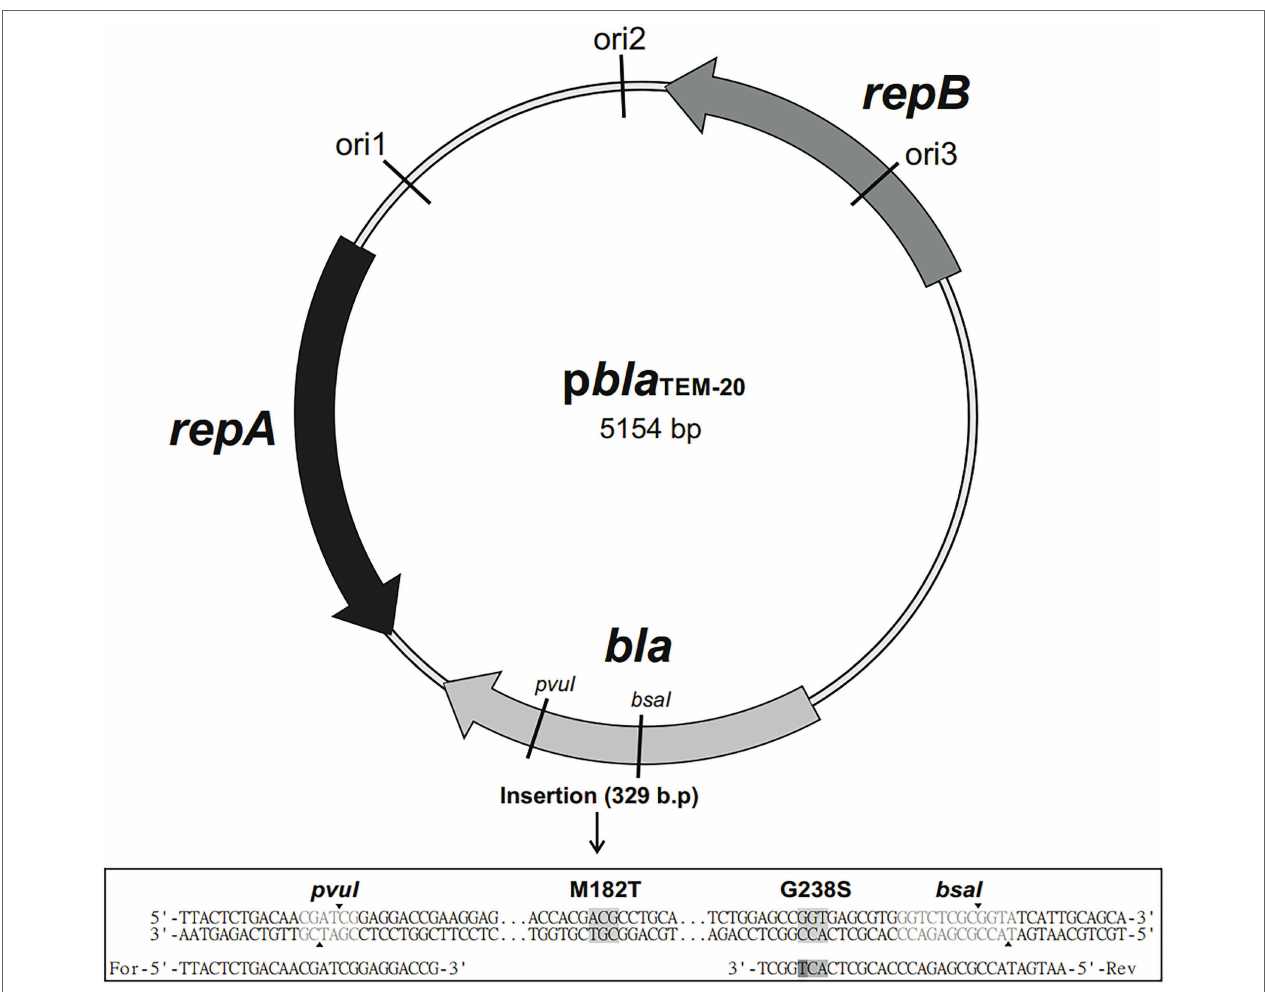
FIGURE 1 | Map of the p bla TEM-20 plasmid (5,154 base pairs long) containing the bla TEM-20 gene associated with resistance to β -lactam antibiotics, including penicillins and cephalosporins. The plasmid contained three replication origins (ori1, ori2, and ori3) compatible with Gram-negative bacteria and the repA and repB genes encoding replication initiation proteins. The nucleotide sequence alignment of a 329 bp insert that contained the portion of the bla gene with the GGT → AGT mutation, which resulted in the Gly → Ser substitution at codon 238, and the ATG → ACG mutation, which resulted in the Met → Thr substitution at codon 182, is shown